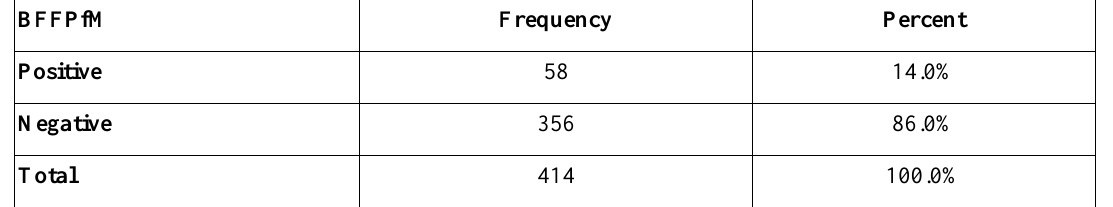
Table 1. Results of blood film for Plasmodium falciparum malaria (BFFPfM).